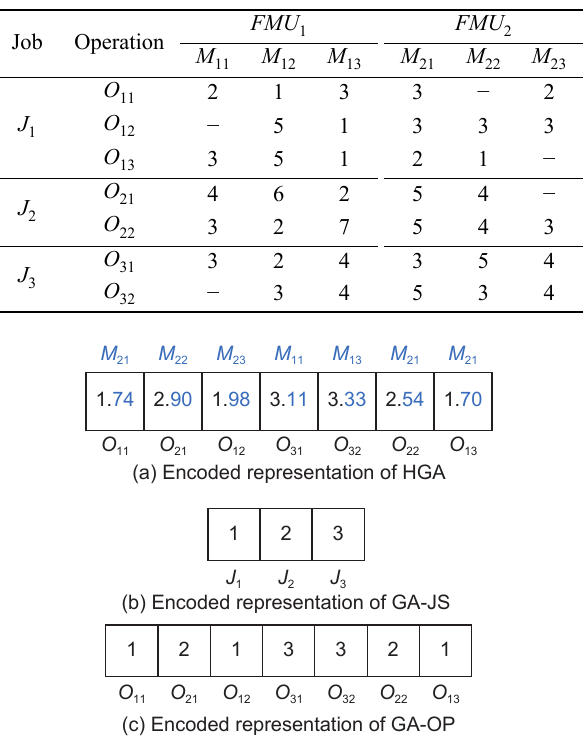
Table 2 A sample DFJSP instance.